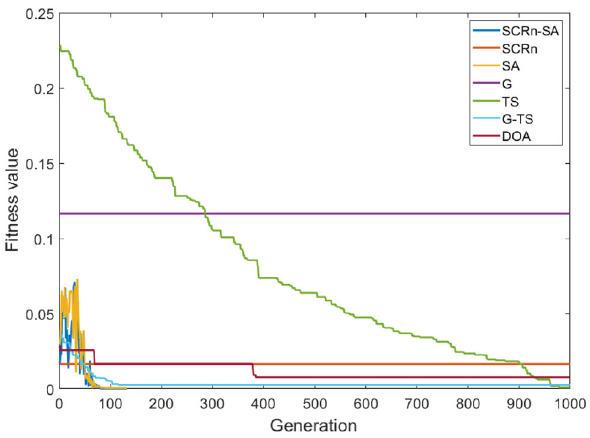
Fig. 3 Convergence curve for f 4